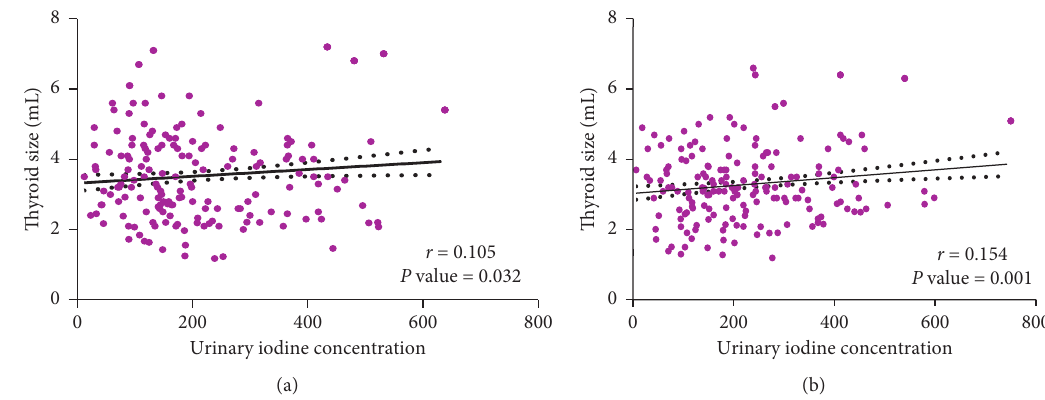
Figure 3: (a) Correlation between urinary iodine concentrations and thyroid volume among female students. (b) Correlation between urinary iodine concentrations and thyroid volume among male